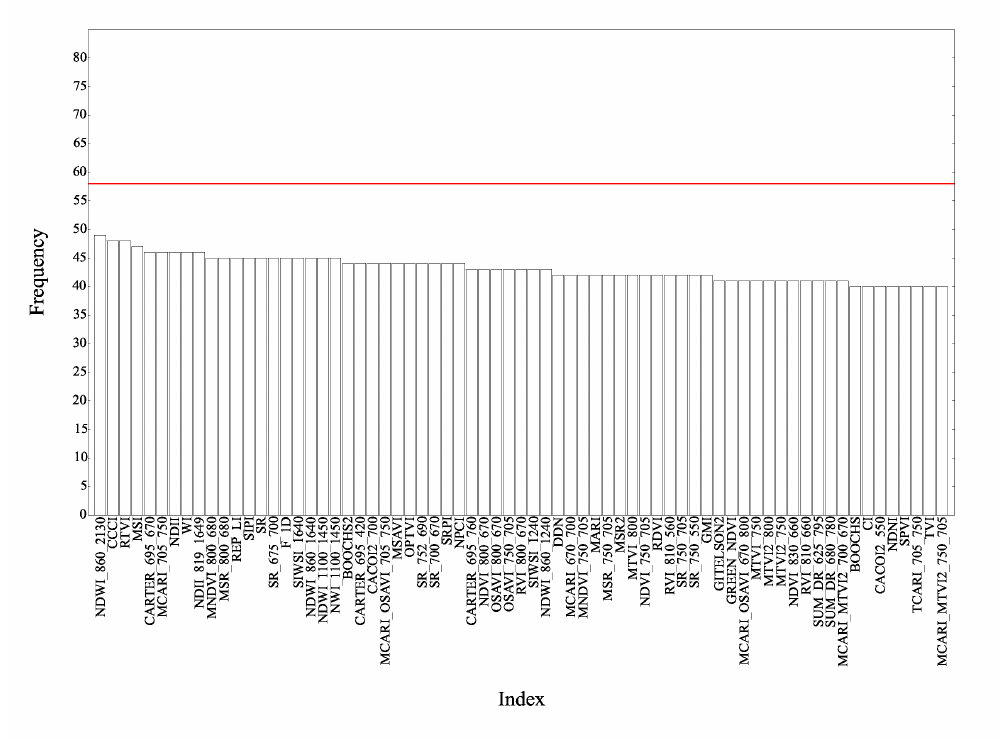
Figure 5. Frequency distribution of the Kruskal-Wallis test for the 129 spectral indices for paired species across the 13 vegetation types. The horizontal red line stands for 75% of all 78 possible combinations of the 13 vegetation